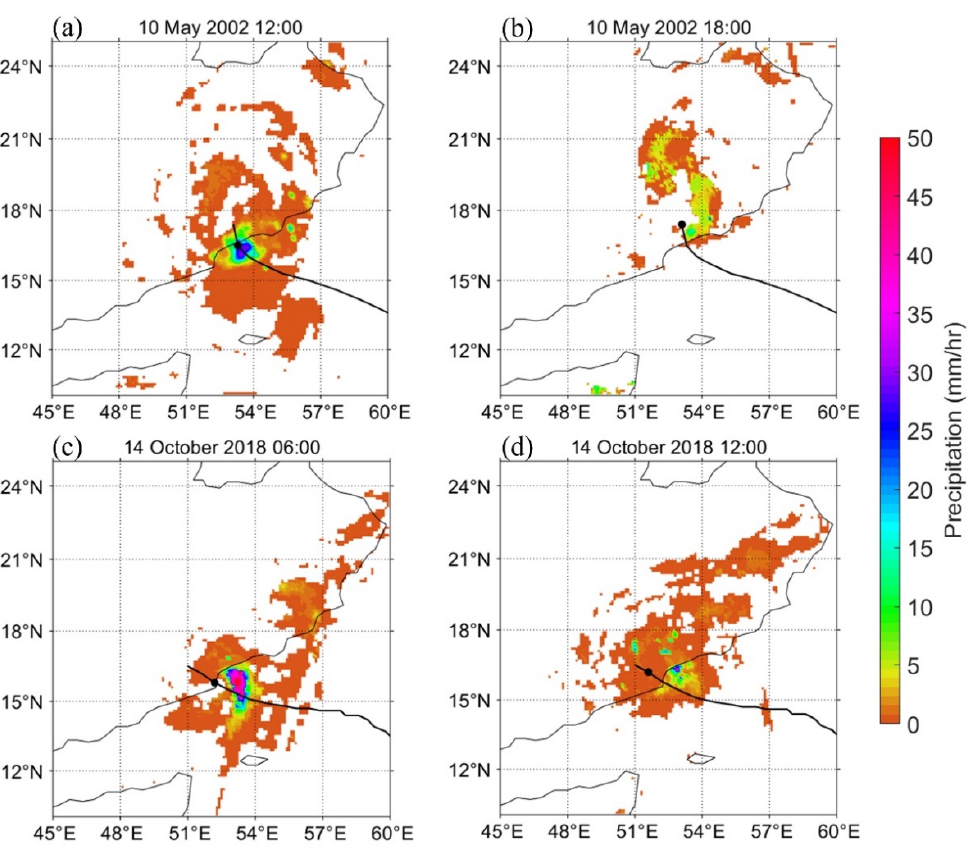
Figure 2. Precipitation (mm/h) distribution for ARB 01 on ( a ) 10 May 2002 12:00 and ( b ) 10 May 2002 18:00, and Luban on ( c ) 14 October 2018 06:00 and ( d ) 14 October 2018 12:00. Table 2. Average precipitation rate and maximum precipitation rate in a radius range of 400 km of the TC central pressure.